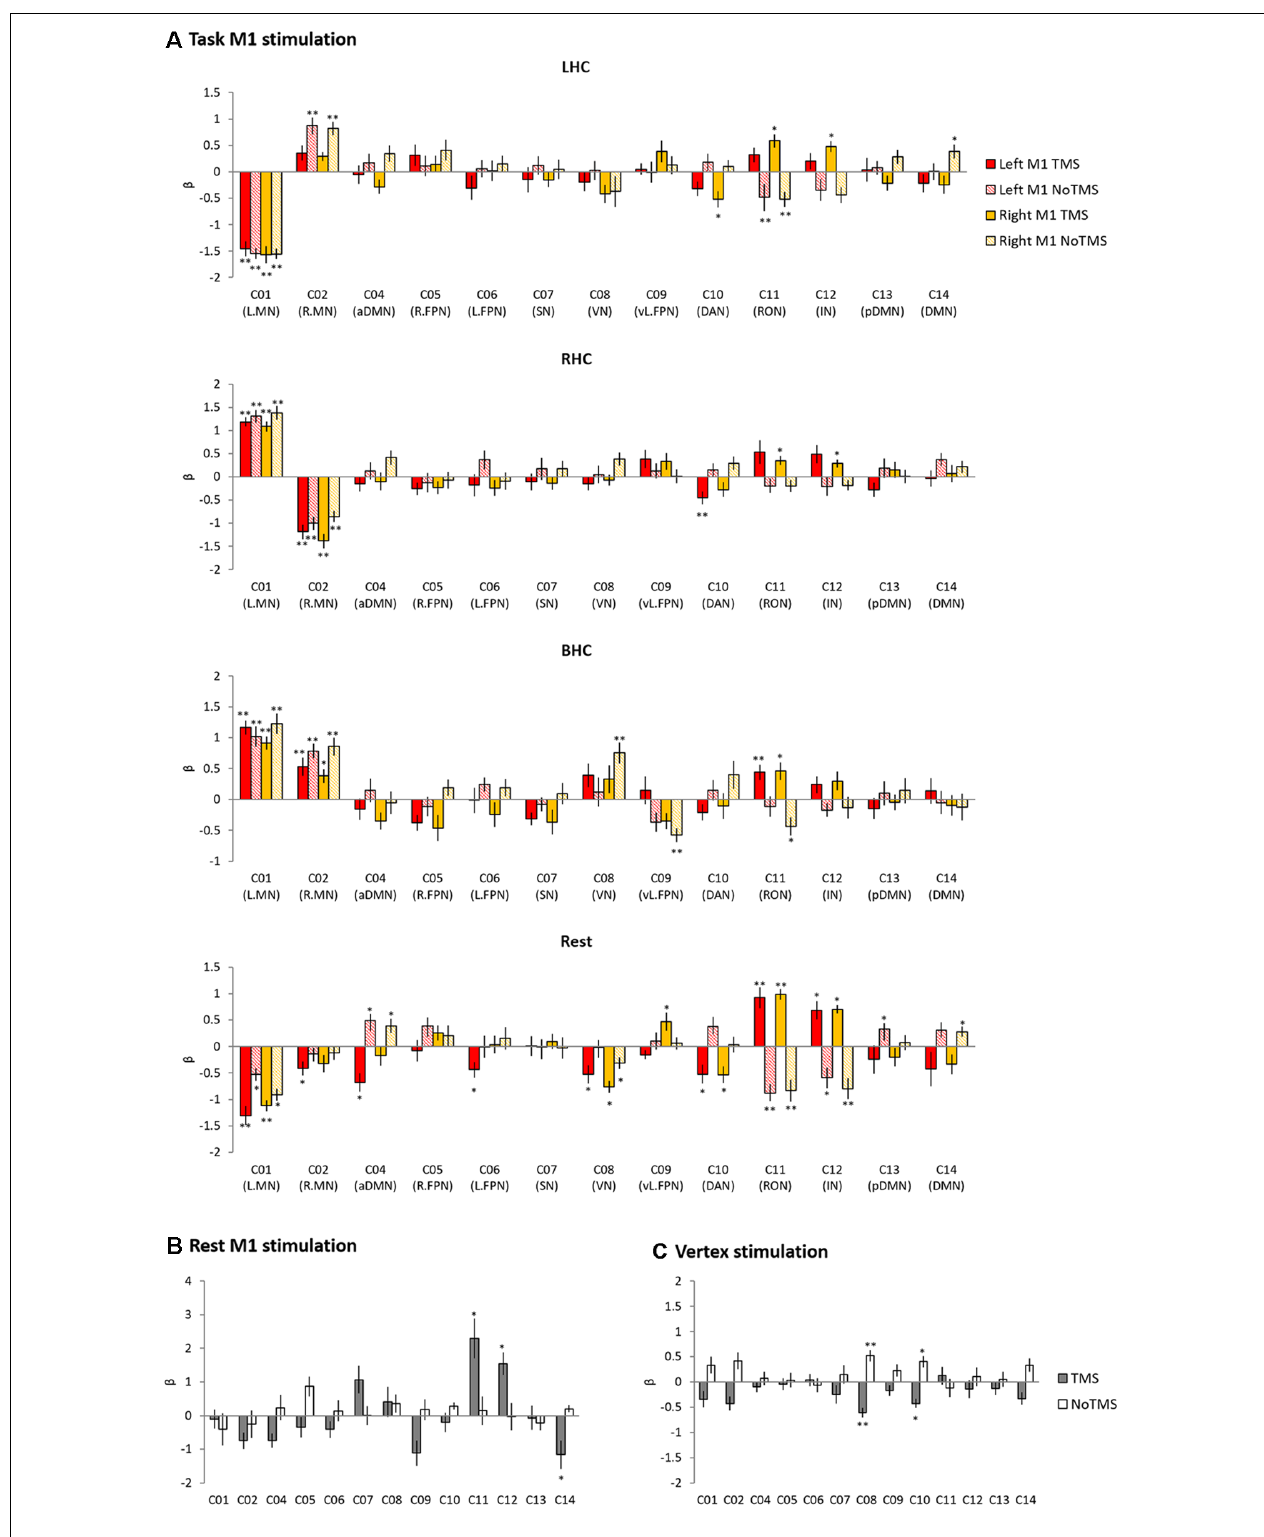
FIGURE 4 | The results of temporal regression analysis. Bar chart showing the mean β value for each condition from a regression analysis performed on each of the 13 networks. (A) Task M1 stimulation. (B) Rest M1 stimulation. (C) Vertex stimulation. Error bars indicate standard errors. ∗ p FDR-corrected < 0.05, ∗∗ p < FDR-corrected